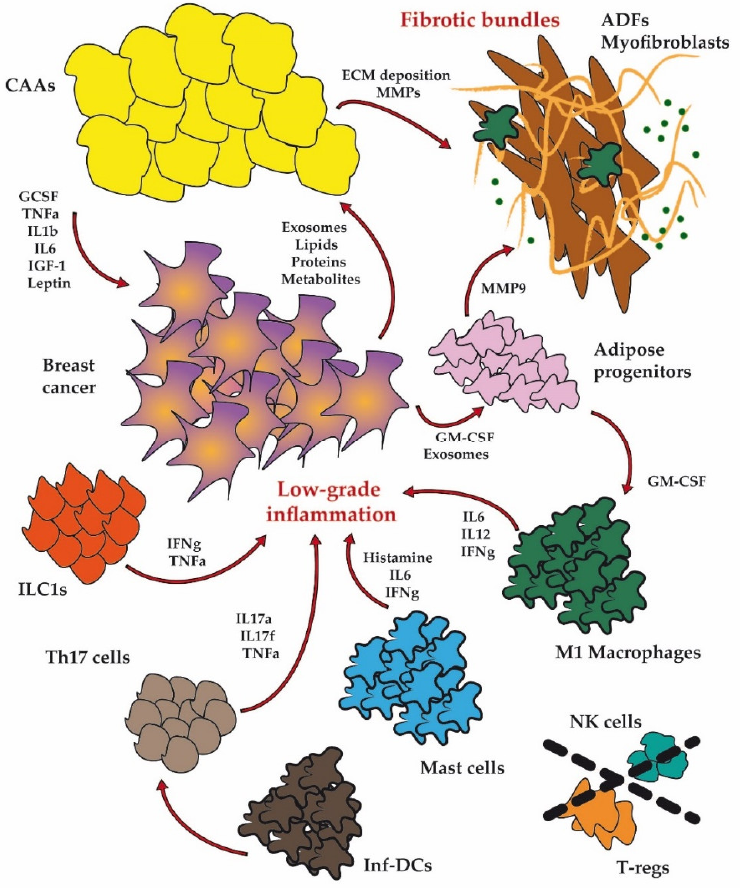
Figure 1. In the case of obesity, white adipose tissue (WAT) is characterized by dysfunctional cel- lular players, which are interconnected in a network of abnormal regulation and intercellular sig- naling. Collectively, these alterations and the bidirectional cross-talk with breast cancer cells lead to abnormal extracellular matrix (ECM), fibrosis, low-grade chronic inflammation, and further prompt cancer progression. CAAs: cancer-associated adipocytes; ADFs: adipose-derived fibroblasts; Inf-DCs: inflammatory dendritic cells; ILC1s: innate lymphoid cells type 1; T-regs: T-regulatory cells; NK: natural killer cells.